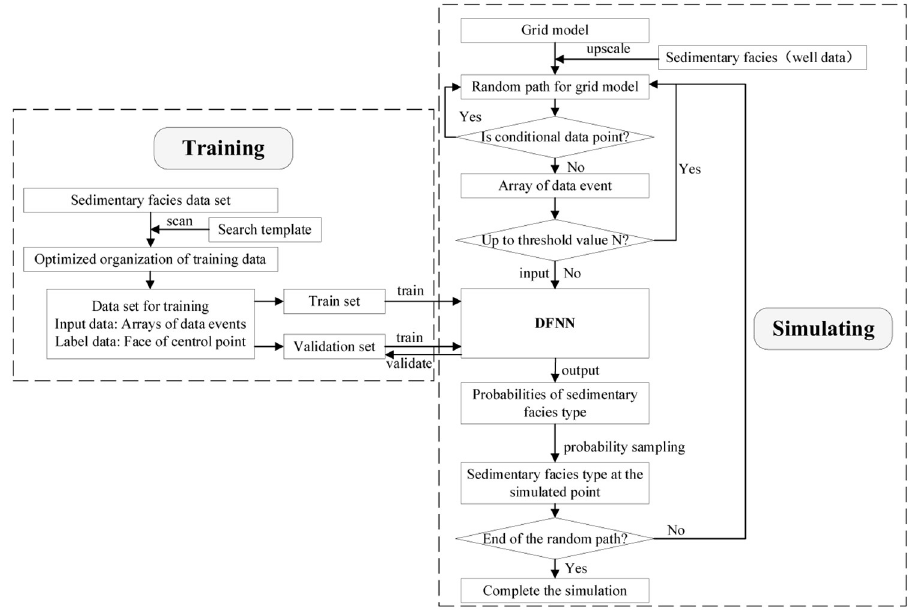
Fig 3. Overall procedure